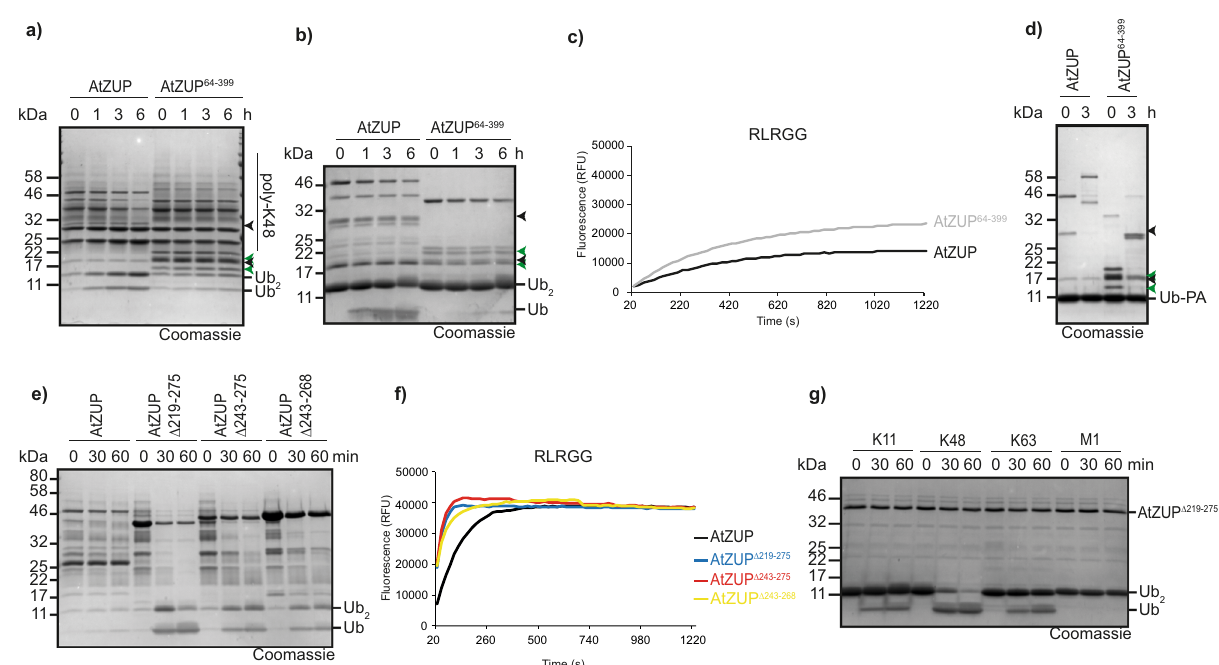
Fig. 6 Ubiquitin chain cleavage by AtZUP is dependent on UBZ. a – d Activity assays of FL AtZUP or UBZ-truncated AtZUP 64 – 399 against K48-linked ubiquitin chains ( a ), K48-linked di-ubiquitin ( b ), RLRGG-AMC ( c ), and Ub-PA ( d ). Arrowheads mark the N- and C-terminal fragments of FL AtZUP (black) or AtZUP 64 – 399 (green). e , f Activity assays of FL AtZUP and the internal truncations AtZUP Δ 219 – 275 , AtZUP Δ 243 – 275 or AtZUP Δ 243 – 268 against K48-linked ubiquitin chains ( e ) or RLRGG-AMC ( f ). g Linkage speci fi city analysis with AtZUP Δ 219-275 . A panel of di-ubiquitin chains was treated with AtZUP Δ 219 – 275 for the indicated time points. Source data are provided as a Source Data fi